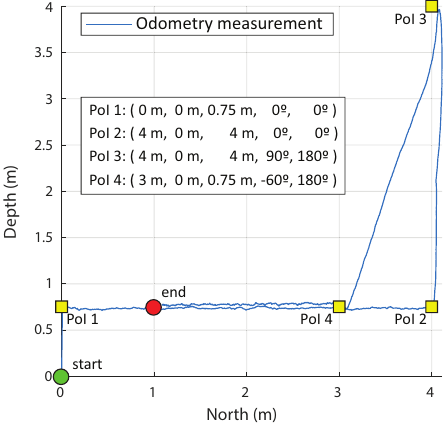
Figure 12. Waypoint control